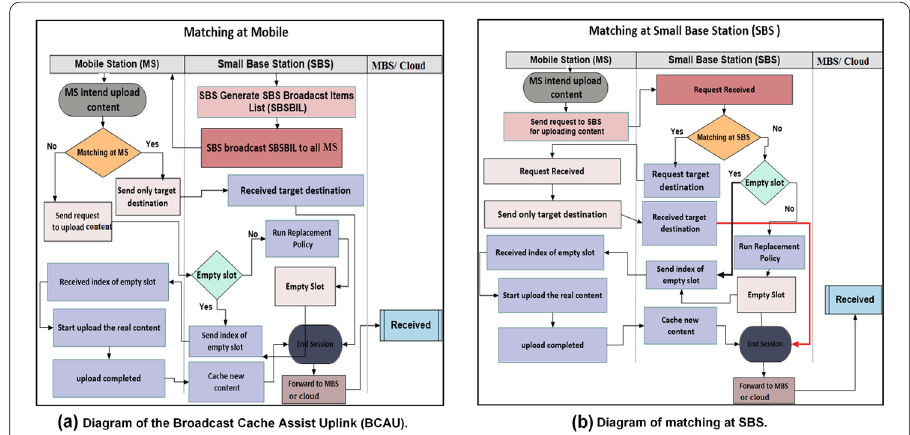
Fig. 2 The framework of the proposed scheme: a diagram of the Matching at the Mobile Station (MS). b Diagram of the Matching at the